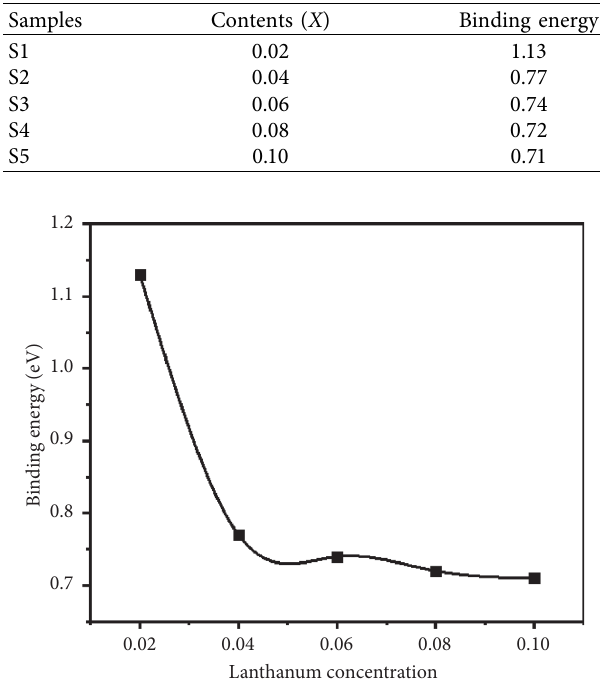
Figure 5: Lanthanum concentration and binding energy of manganese barium